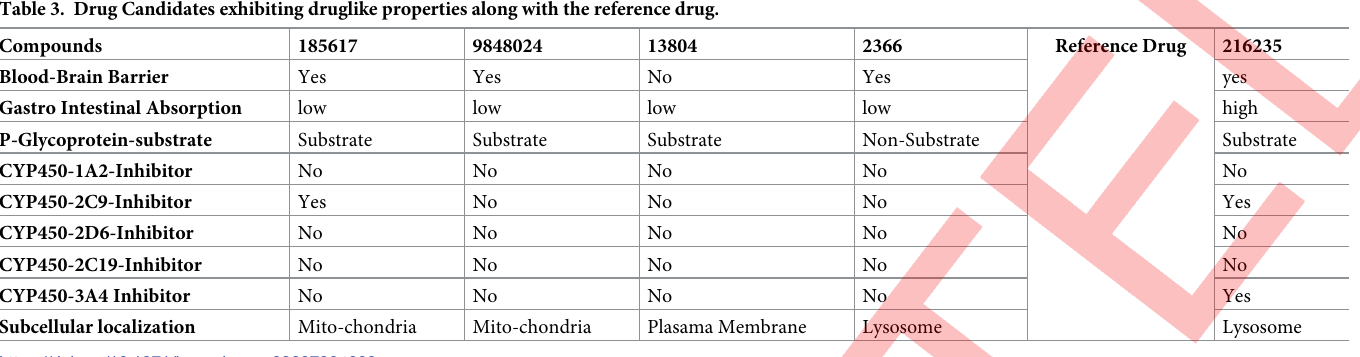
Table 3. Drug Candidates exhibiting druglike properties along with the reference drug. Compounds